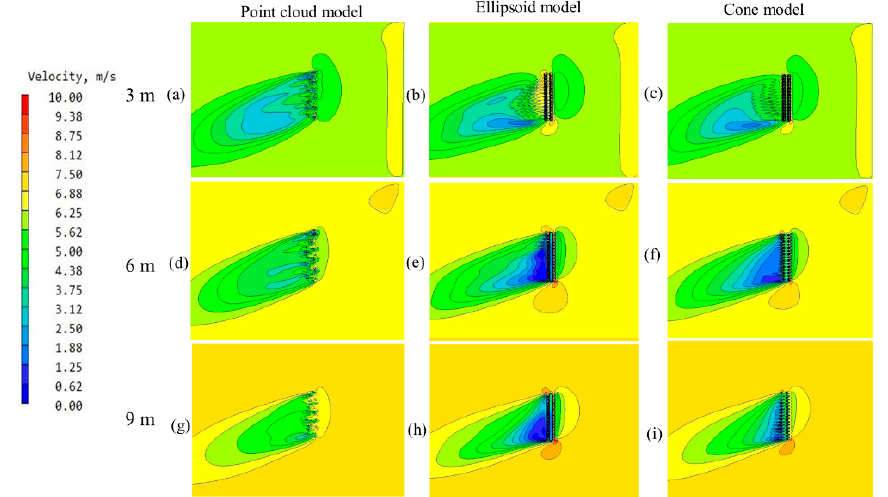
Figure 10. Simulation of the three models in the wind field. The wind speed distribution character- istics around the protective forest at different heights represent different wind speeds (0, 2, 4, 6, 8, 10 m/s), blue, green, and yellow areas represent the airflow distribution characteristics at different heights; the blue area has the lowest wind speed. The wind speed in the yellow region ranges from 8 < v < 10; green is 4 < v < 8; and blue is 0 < v < 4. From ( a , d , g ), we can see that the wind speed decreases as the height increases. But in ( b , e , h ) and ( c , f , i ), there are some positions that are contrary to the actual situation. This may be the result of different canopy